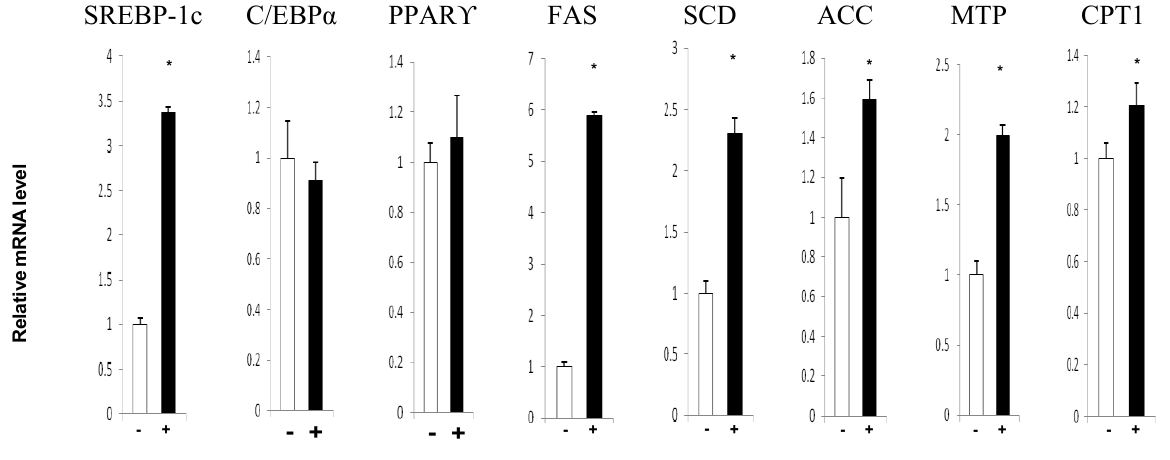
Figure 3. Effect of TAM on the mRNA expression of genes regulating lipid metabolism in HepG2. The effects on mRNA expressions of SREBP -1c, C/EBP α, PPAR γ, FAS , SCD